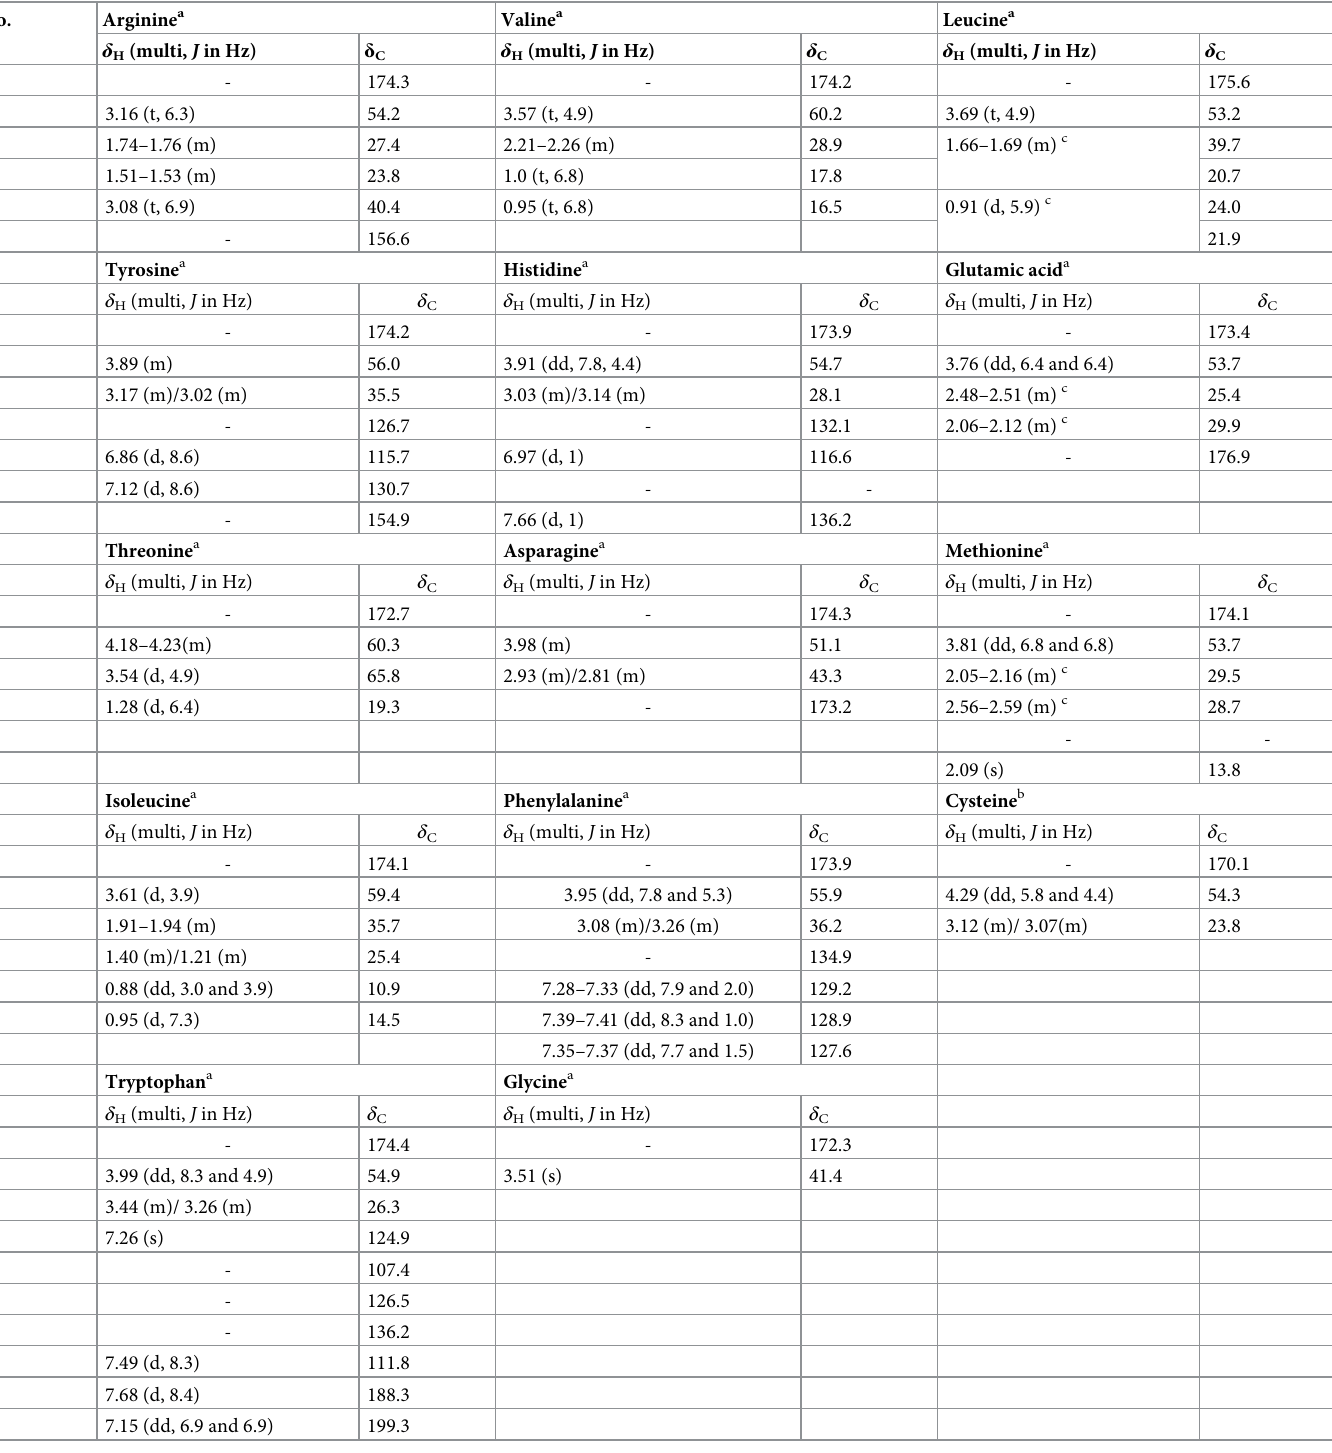
Table 1. 1 H and 13 C NMR spectral data of amino acids a,b